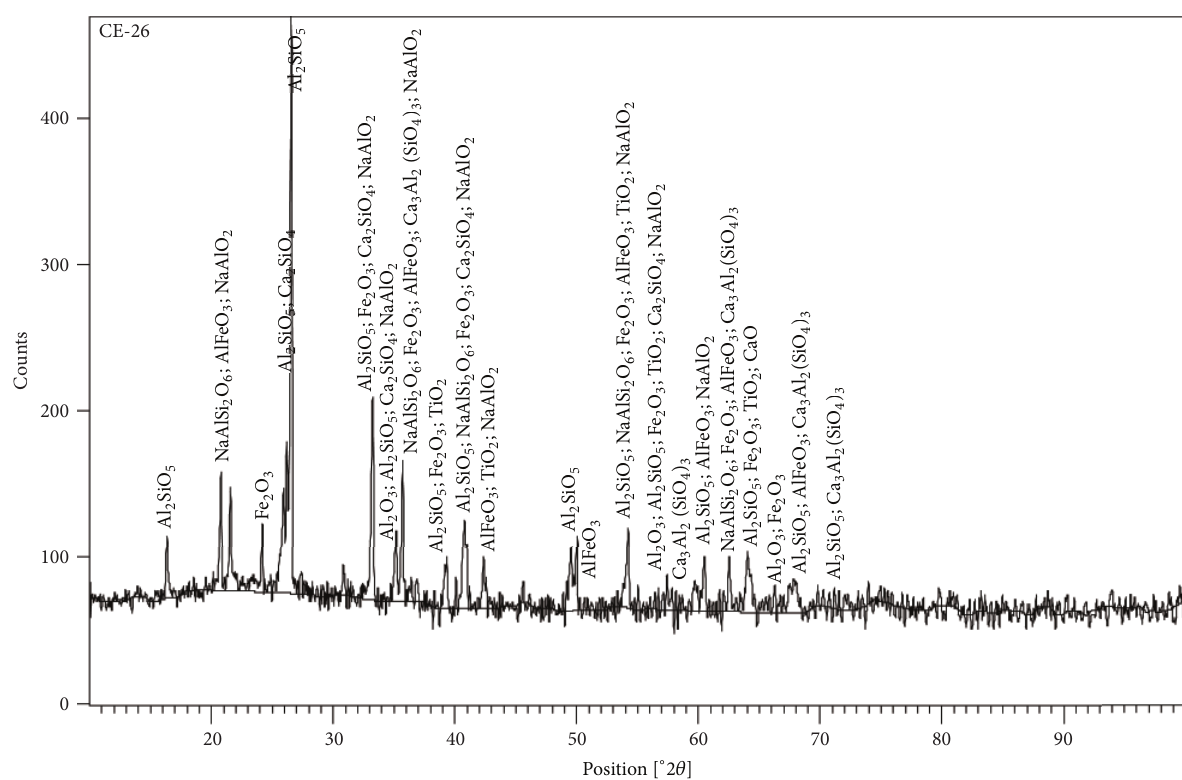
Figure 2: Mineralogical phases of sintered red mud mix with fly ash (XRD). Conditions: red mud: fly ash (1:3) with 10% water, 1100 ∘ C.